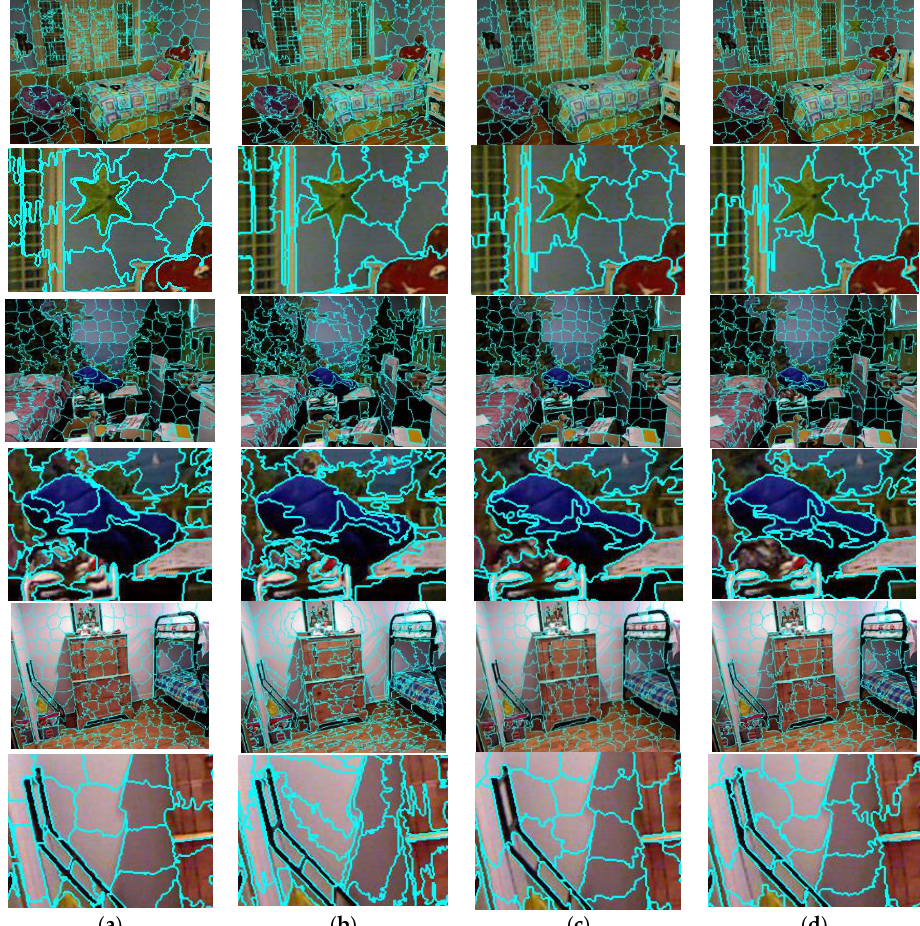
Figure 9. Visual comparison of superpixels with K = 200 on NYUv2. ( a ) SNIC; ( b ) FLIC; ( c ) SNIC; ( d ) NICE. Alternating columns show each segmented image followed by local details of each